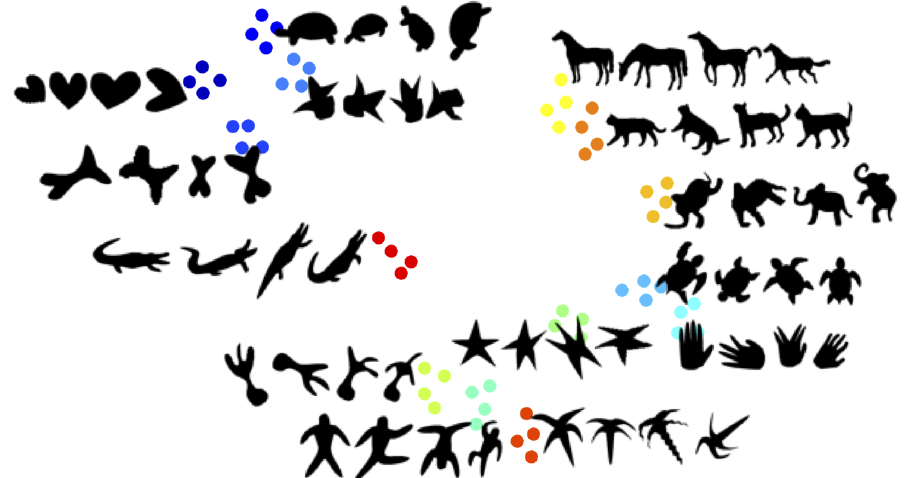
Figure 5. t-SNE mapping of the shapes from the dataset [3] where the points with the same color denote the shapes from the same